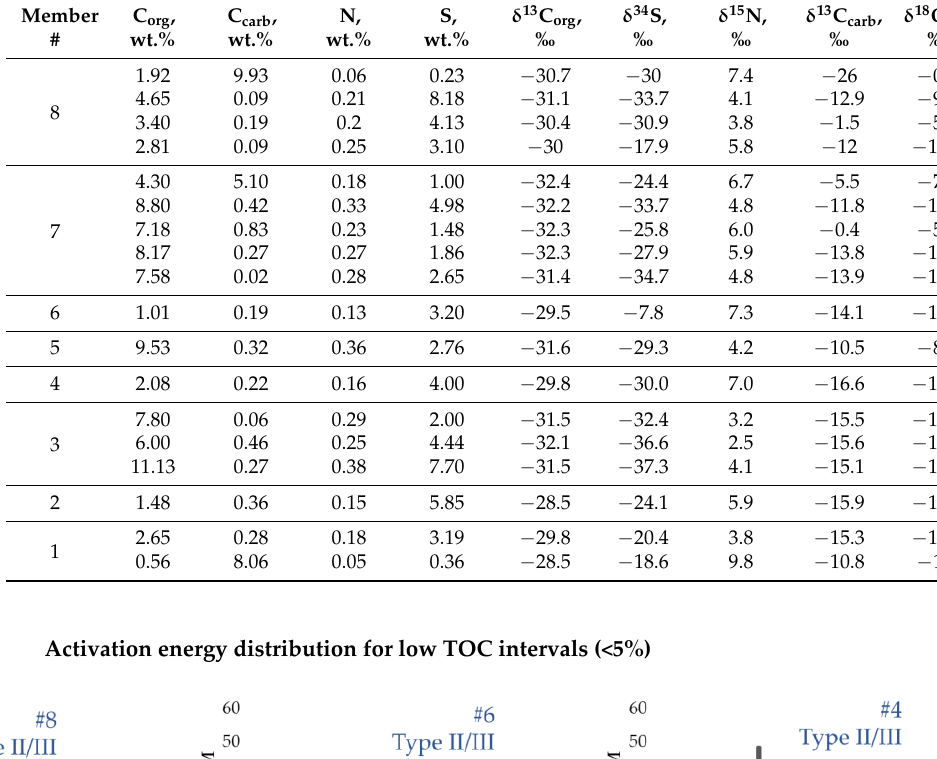
Table A4. Elemental and isotope composition of the rock samples.